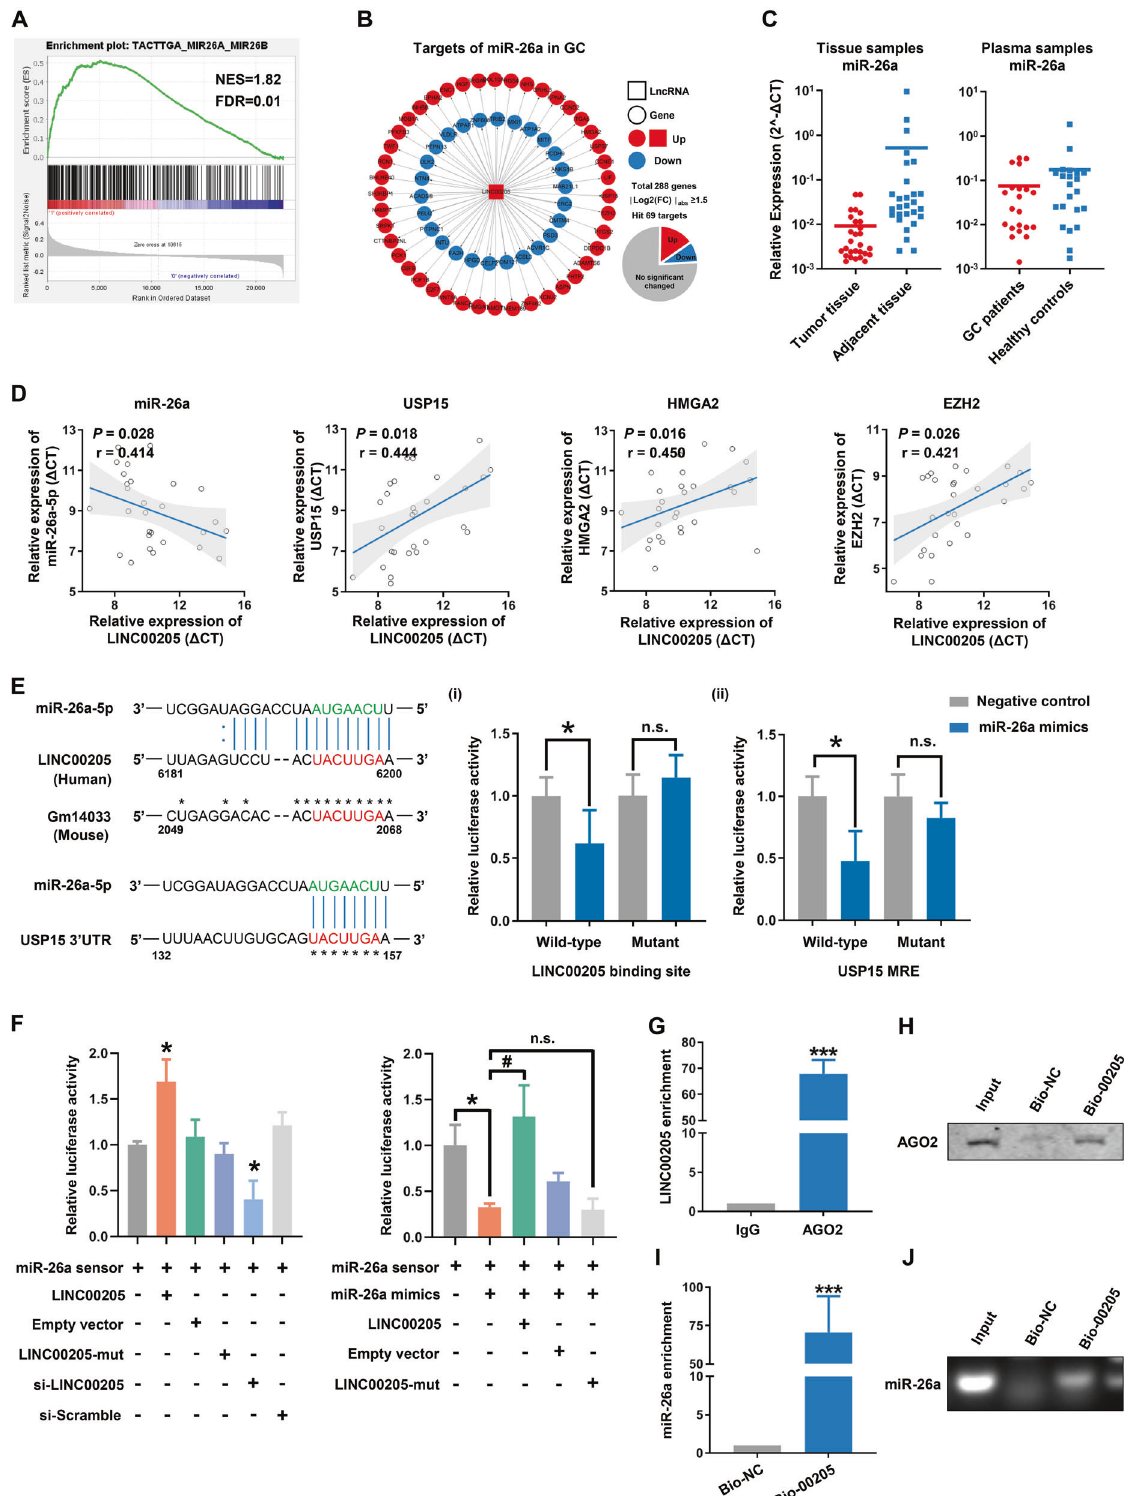
metastasis by modulating miR-26a levels via a competitive inhibition mechanism. Thus, adjusting expression of LINC00205 may provide a novel approach for the diagnosis and treatment of